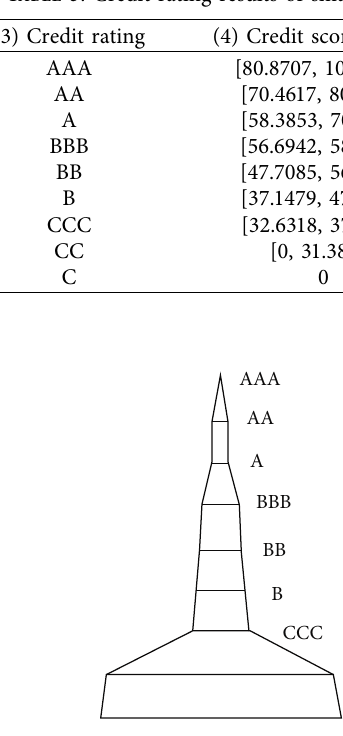
Figure 3: Distribution diagram of the relationship between credit rating and default loss